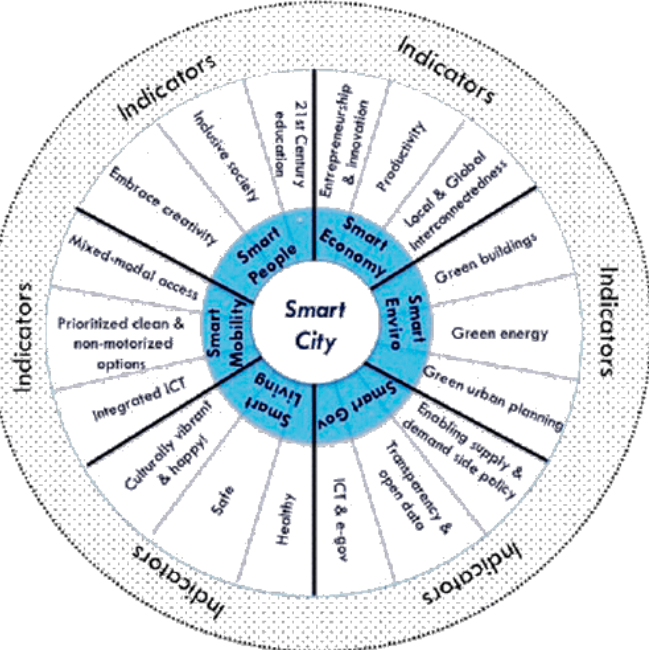
Figure 2. Smart Cities Wheel Model proposed by B. Cohen. Source: Cohen B. [97].